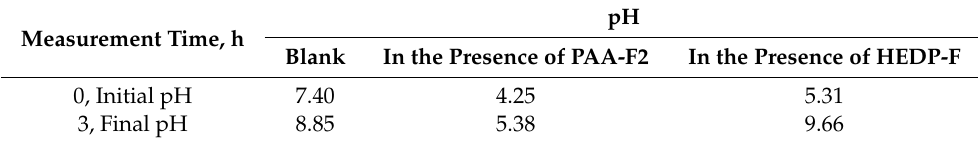
Table 1. pH values in the concentration compartment.